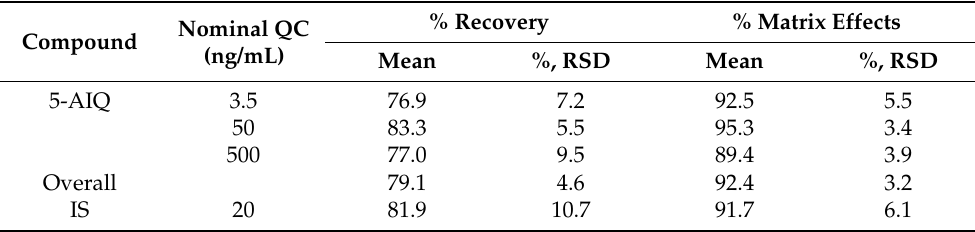
Table 3. The % recovery and % ME of 5-AIQ and IS in human plasma at LQC, MQC and HQC concentration (n =